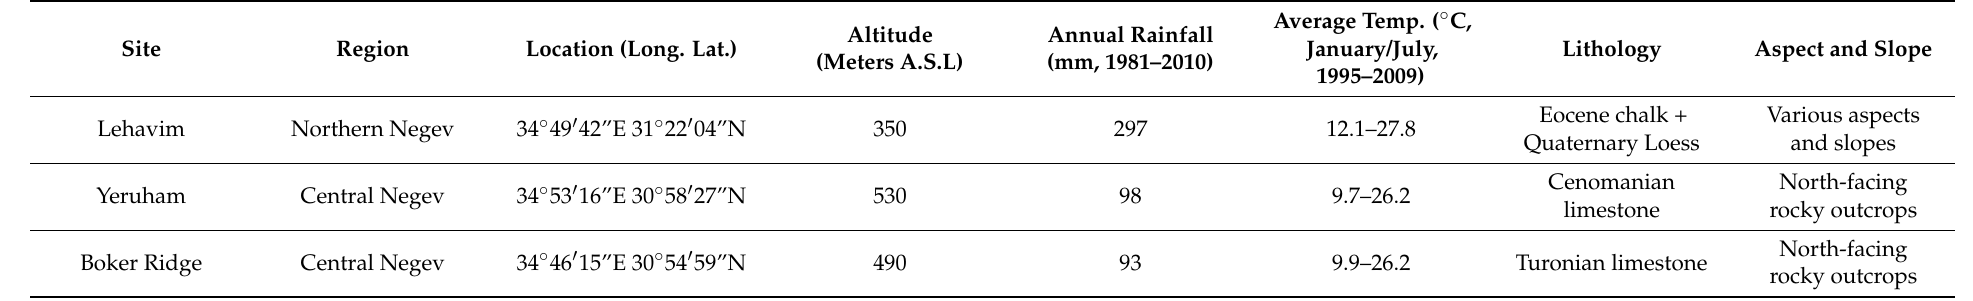
Table A1. Study sites where the distribution of S. clusiana with respect to shrubs was documented. Climate data retrieved from the Israel Meteorological Service website (1). Lithology data was retrieved from the geological map of Israel (2).